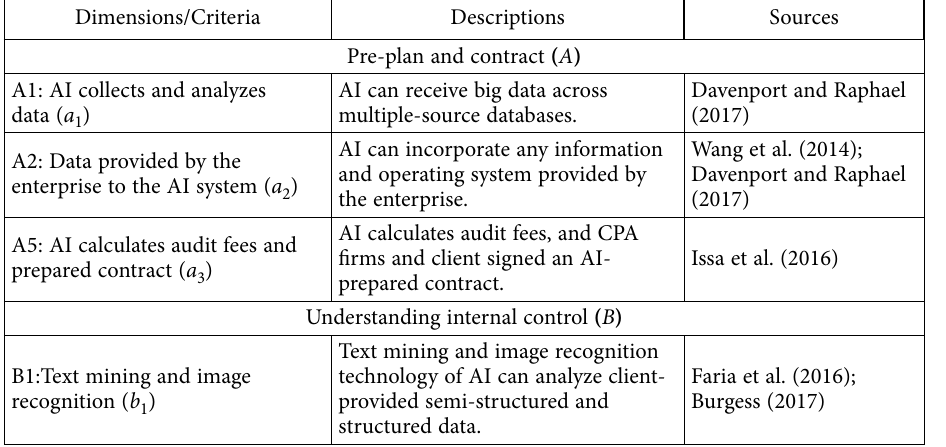
Table 3. The descriptions of selected criteria